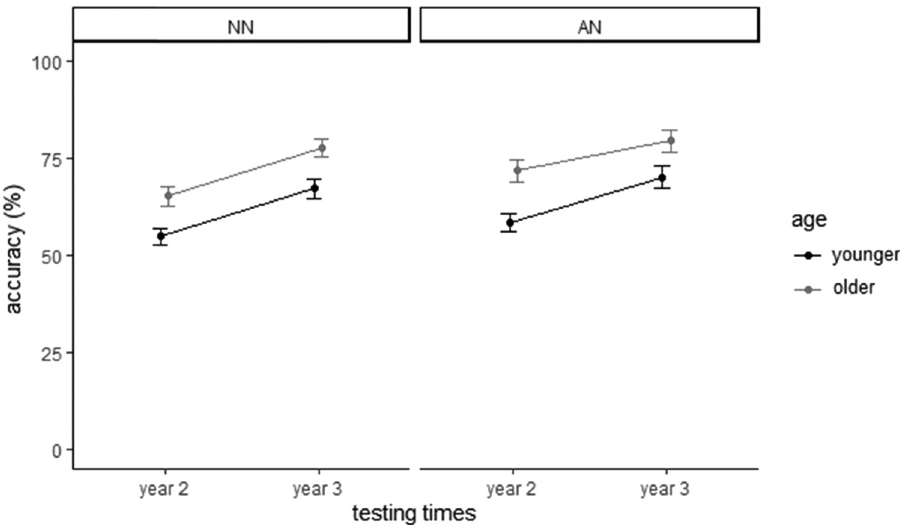
Figure 5: Correct judgments at the two testing times: NN compounds versus AN strings.